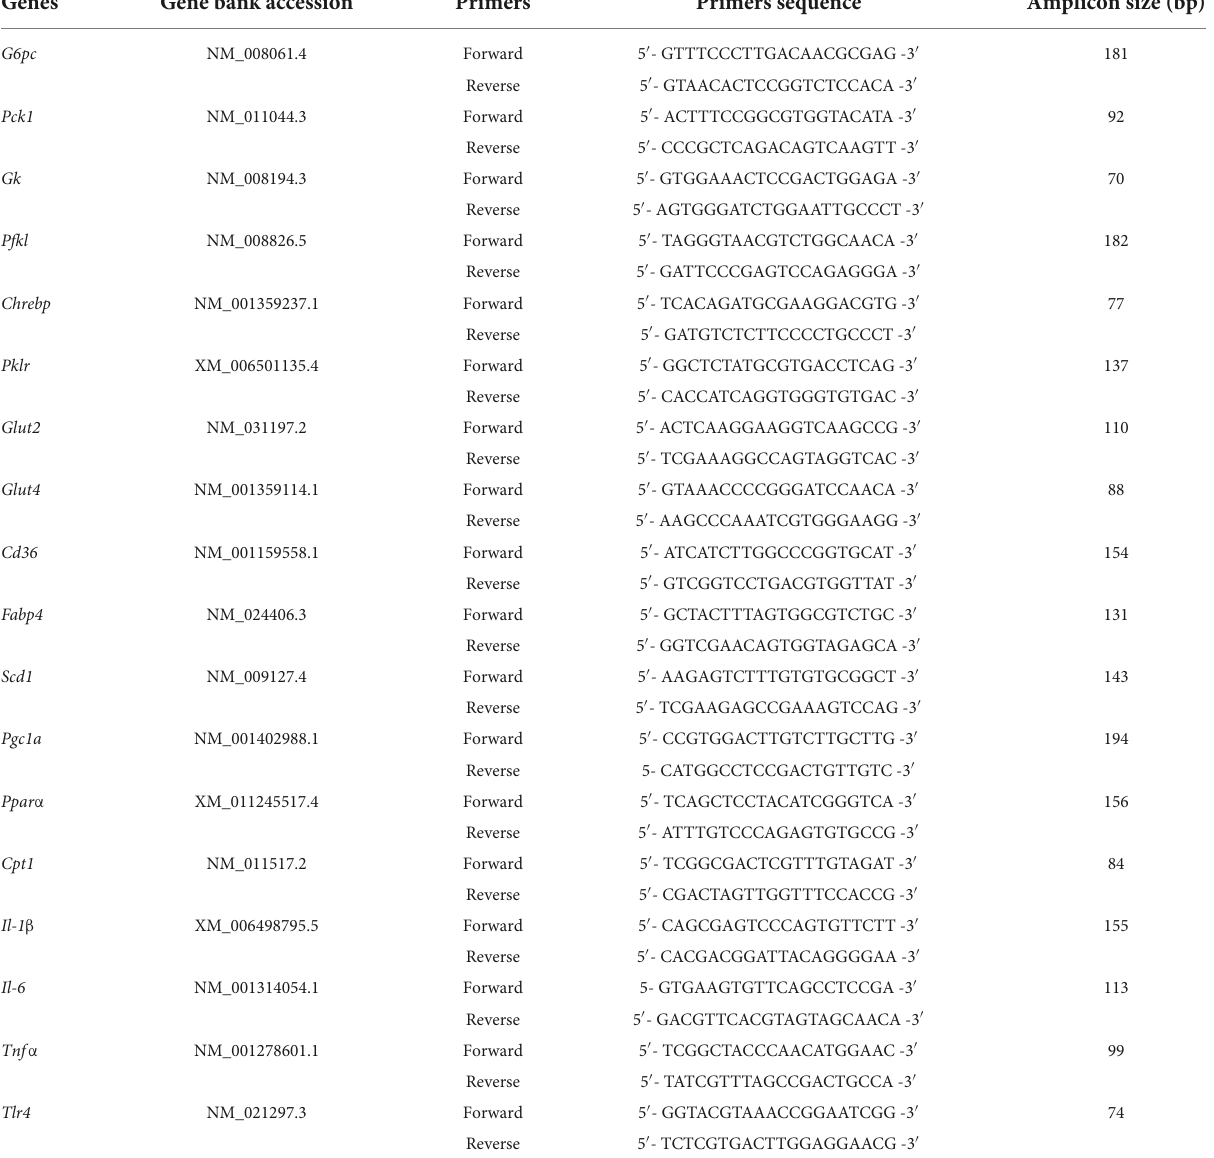
TABLE 1 List of primers used in this